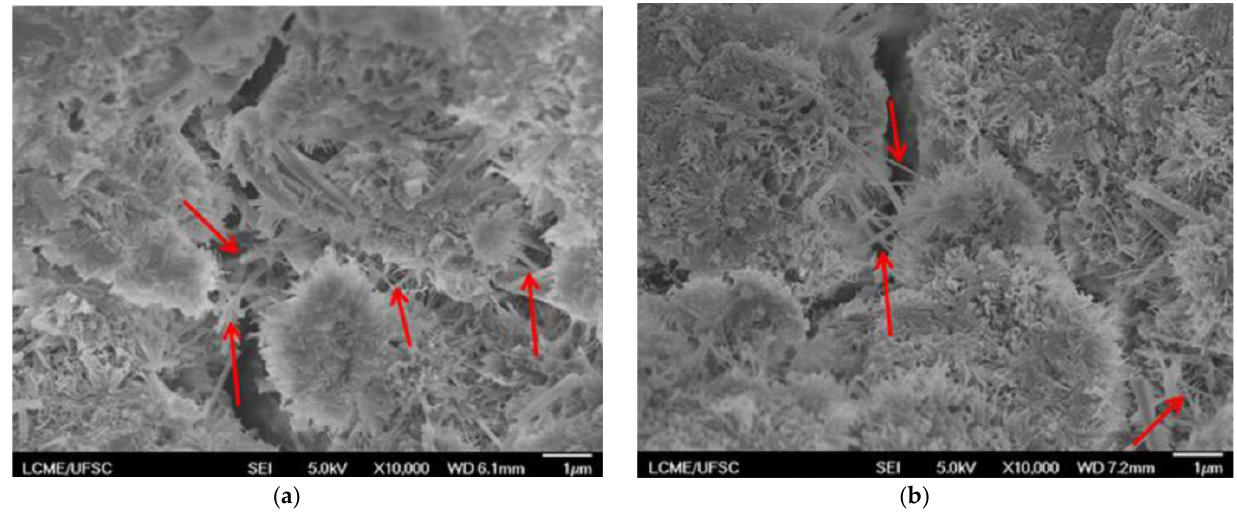
Figure 7. SE-SEM images (×10,000) of ( a ) NT-NW_SP_0.50% and ( b ) 500-NW_SP_0.50% composites at 28 days. The arrows indicate the NWs.